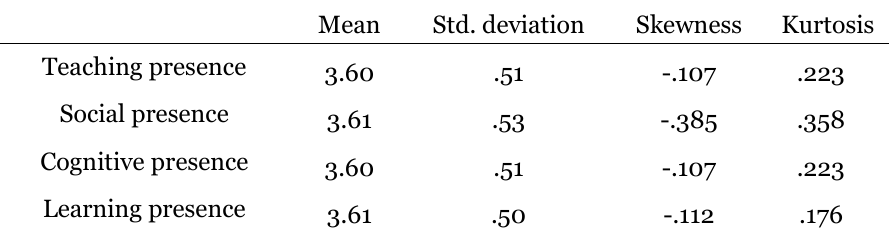
Descriptive Statistics of Four